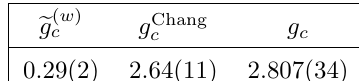
g ( w ) c is the one found in e